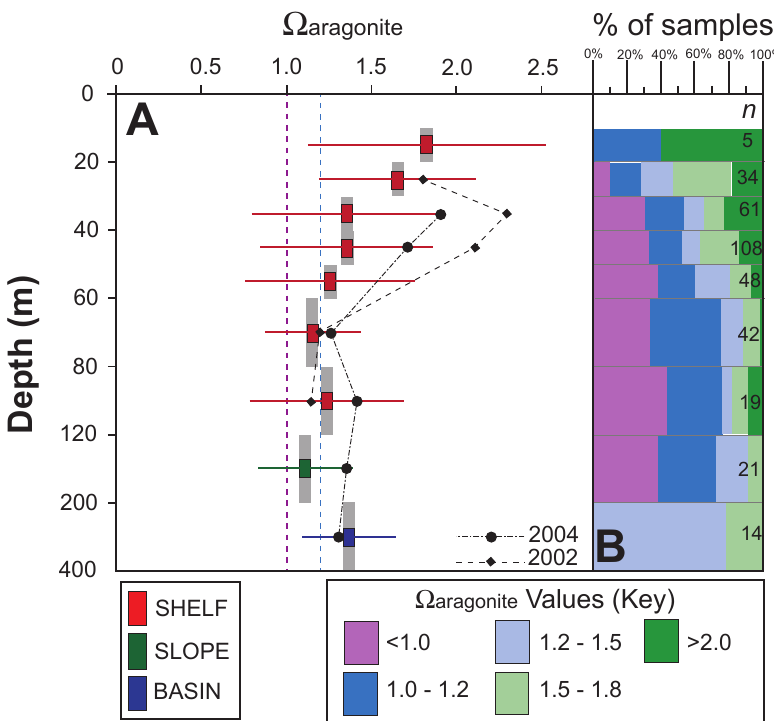
Fig. 8. Composite figure of mean (cid:127) aragonite values for shelf bottom waters from the western Arctic Ocean (includes the Chukchi Sea, eastern East Siberian Sea, western Beaufort Sea shelf) as observed during the 2009–2011 RUSALCA/ICESCAPE expeditions. Limited data from 2002 and 2004 SBI expeditions are also shown in the figure. The panels include (A) mean (cid:127) aragonite values for shelf (red symbol), slope and basin for different depth intervals. The standard deviation of mean shelf (cid:127) aragonite at each depth interval is shown in light red, and gives some indication of range of (cid:127) values. The vertical height of each mean (cid:127) aragonite value shows the depth interval (i.e., 0–5m for uppermost depth interval); (B) the % of sampled water within the defined (cid:127) ranges (i.e., < 1.0 is shown as purple; 1.0–1.2 as deep blue; 1.2–1.5 light blue; 1.5–2.0 as light green; and > 2.0 as dark green. This color coding of (cid:127) aragonite values is identical to Fig. 6. Limited data from 2002 and 2004 SBI expeditions are also shown in the figure. In (B) , the number of samples (i.e., n of sample within the depth horizon) that comprise each binned depth horizon is given in the right-hand corner of each depth bin, replicating n values given in Table